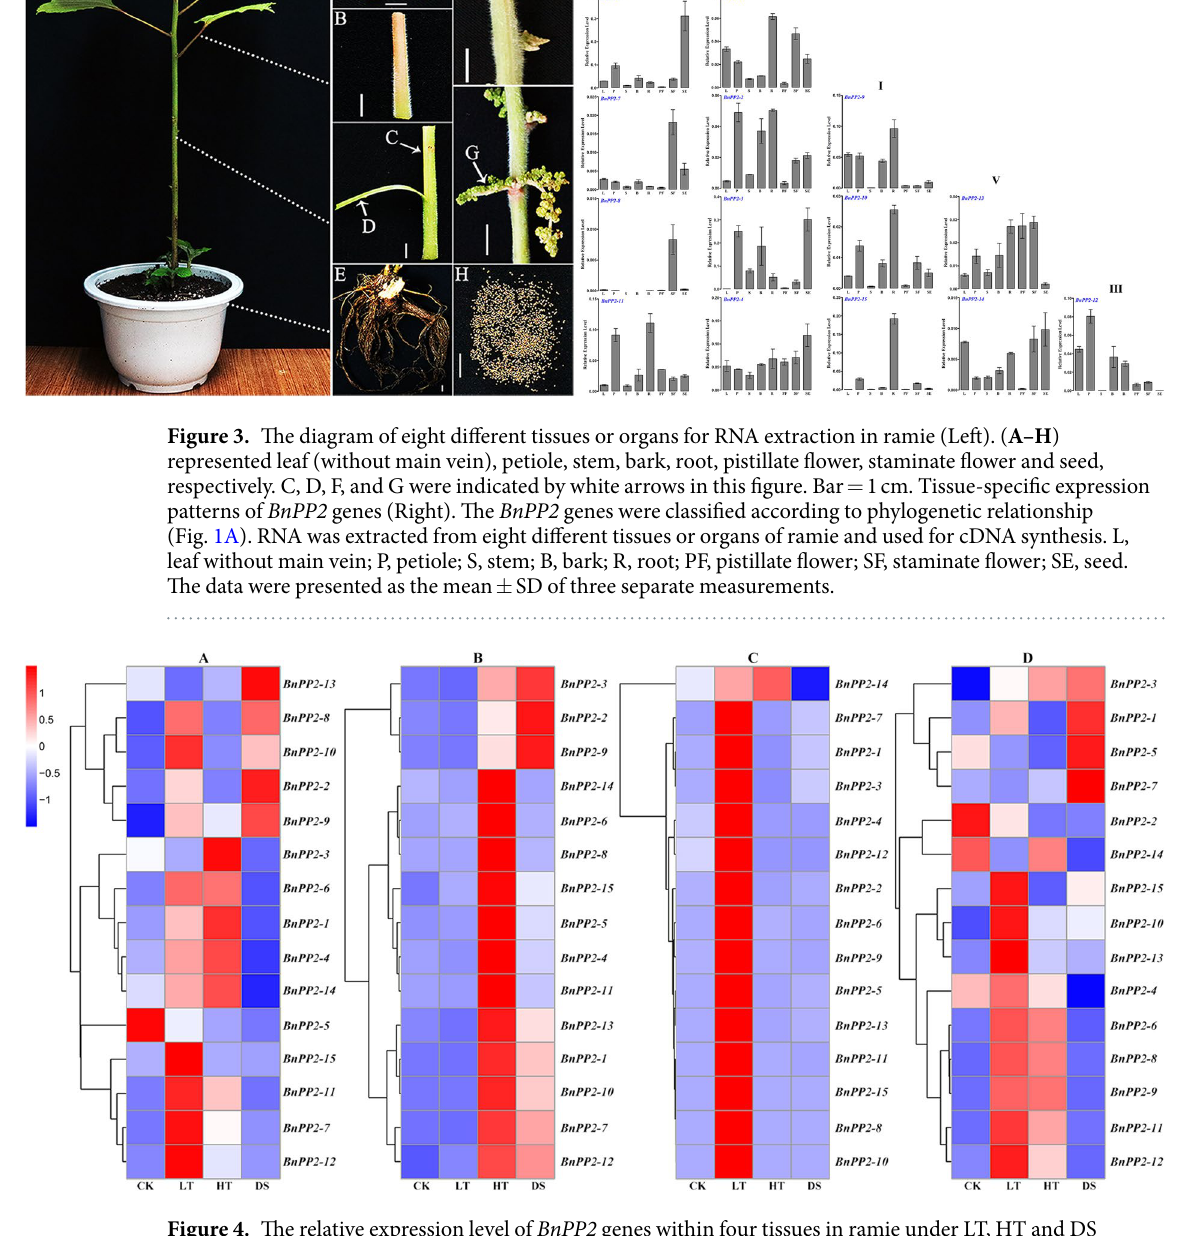
In the MW treatment, the expression patterns of nine BnPP2 genes were similar in the leaves and bark. The expression levels of BnPP2-1 , BnPP2-2 , BnPP2-3 , BnPP2-4 and BnPP2-14 were down-regulated, whereas the expression levels of BnPP2-10 , BnPP2-11 , BnPP2-13 and BnPP2-15 were up-regulated, and the expression levels of BnPP2-6 , BnPP2-7 , BnPP2-8 , BnPP2- 9 and BnPP2-12 were up-regulated in leaves and down-regulated in the bark. In addition, the expression level of BnPP2-5 was up-regulated in the bark and down-regulated in leaves (Fig. 5A).